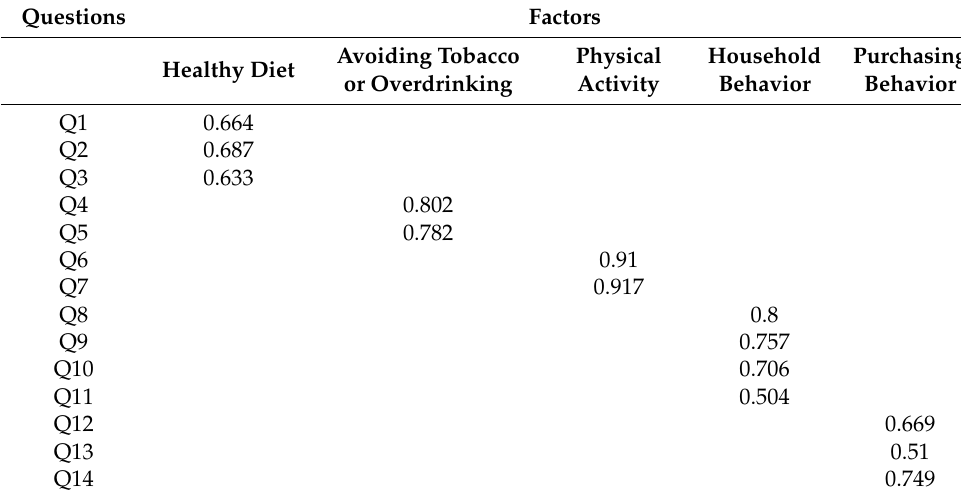
Table 4. The results of exploratory factor analysis.